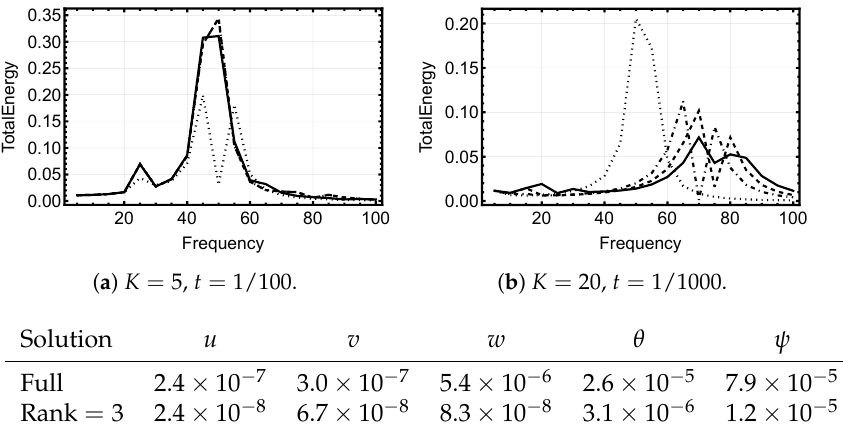
Figure 6. Low-rank approximation. Convergence of the low-rank approximation as the number of the Krylov basis vectors grows. Solid line: full, dotted: rank = 2, , dot-dashed: rank = 3, dashed: rank = 4. The θ -components explain the difference in the observed energies at f = 70.